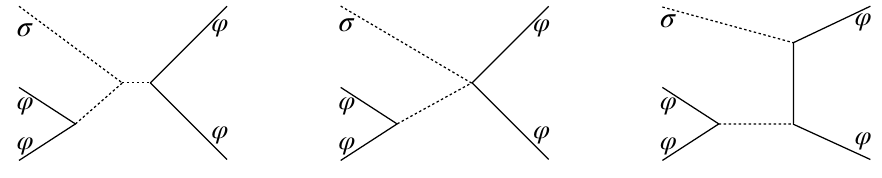
Figure 4 . The leading order Feynman diagrams of σϕϕϕϕ